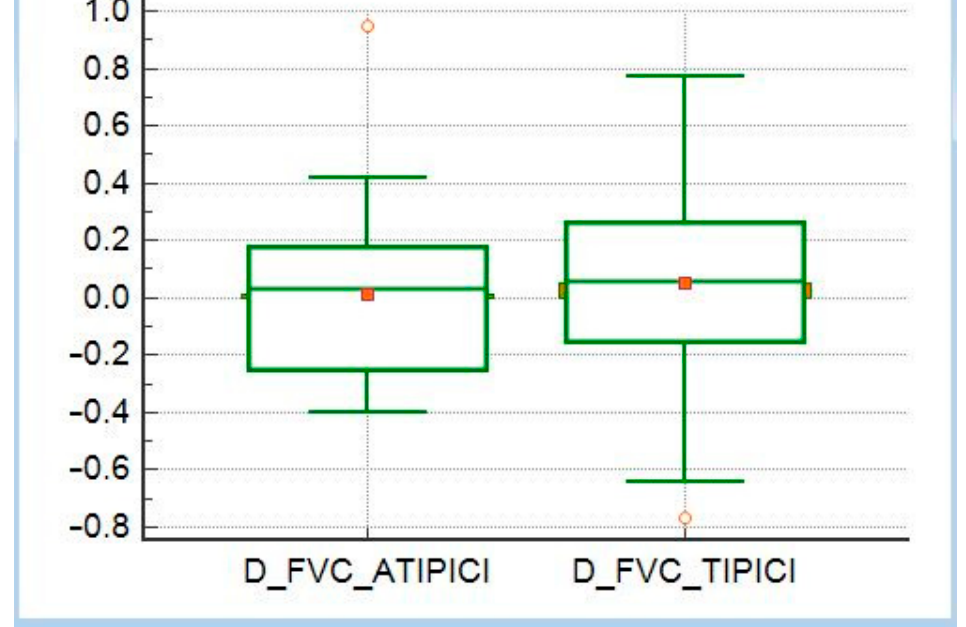
Figure 11. Comparison between means of diffusing capacity for carbon monoxide (DLCO) variation in patients with typical and atypical high-resolution computed tomography (HRCT) patterns.